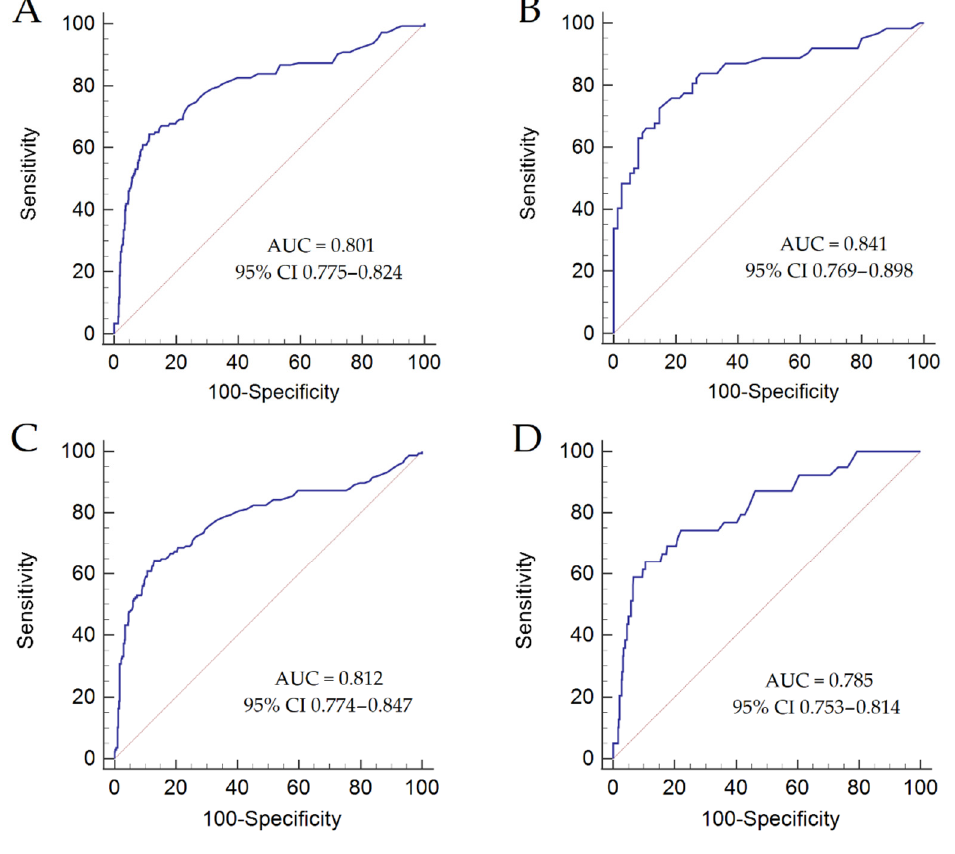
Figure 2. PIVKA-II ROC curves for the detection of HCC in patients with viral ( A ) and non-viral etiology ( B ), and according to sex (( C ) = males; ( D ) = females). Abbreviations: AUC, area under the curve; CI, confidence interval.